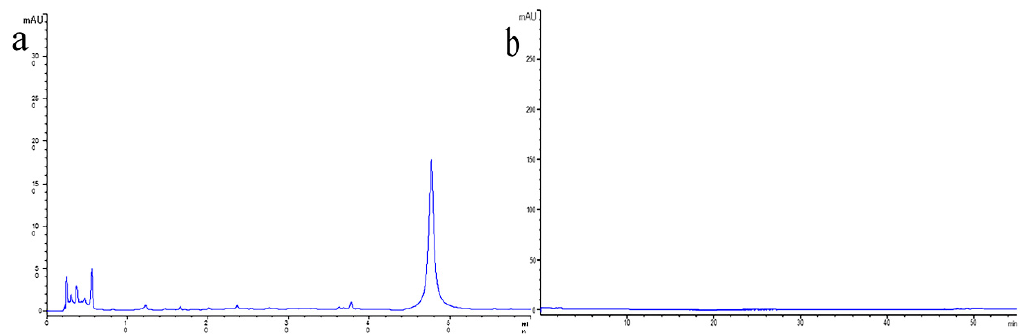
Figure 2. High-performance liquid chromatography (HPLC) fingerprint of ( a ) ST (the all dry grass of Selaginella tamariscina (Beauv.) Spring) and ( b ) Selaginella tamariscina Carbonisata